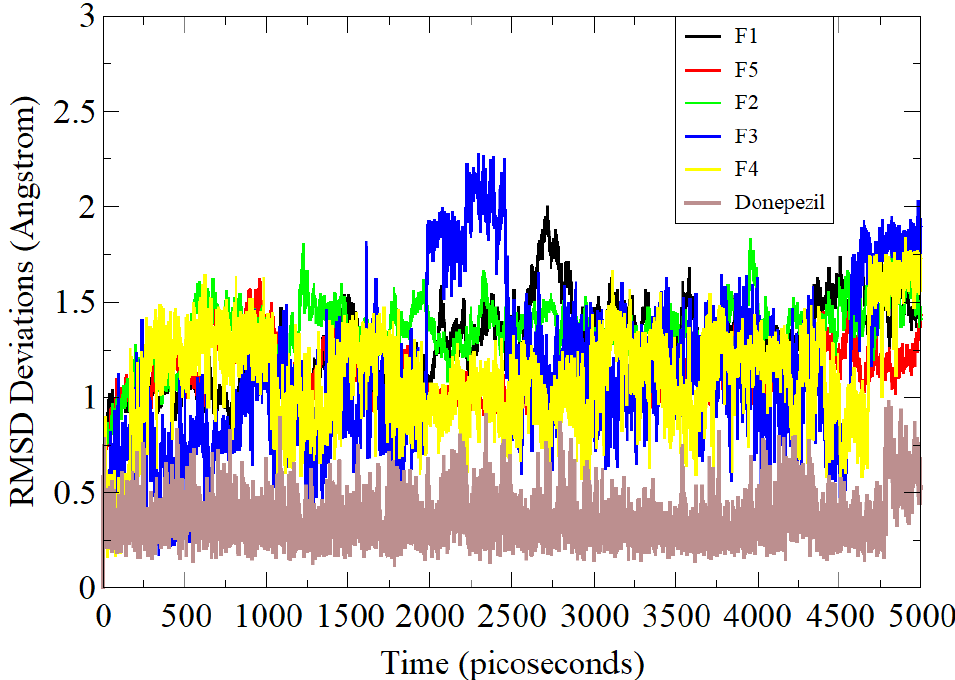
Figure 3. Simulation-based RMSD analysis of tested compounds and standard control AChE com- plexes.